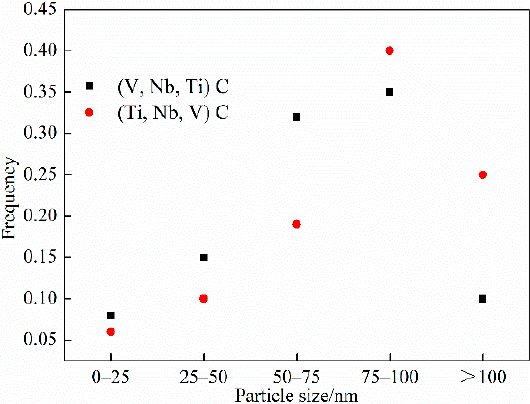
Figure 15. Images of (V, Nb, Ti) C precipitates in the experimental steel at 650 °C for five passes of thermal simulation. Images of ( a ) (V, Nb, Ti) C precipitates and ( b ) EDS of Nb, V, and Ti.